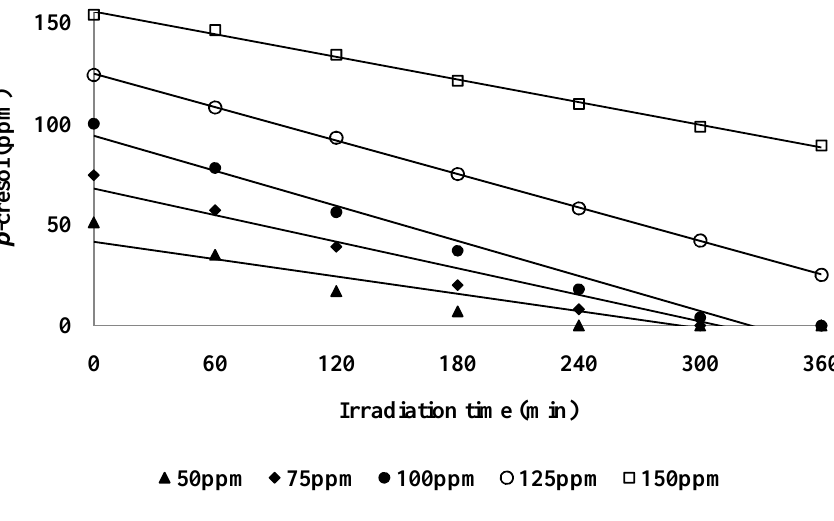
Figure 3. Effect of p -cresol concentration on photocatalytic degradation under UV irradiation, initial condition: amount of photocatalyst = 2.5g/L and pH =